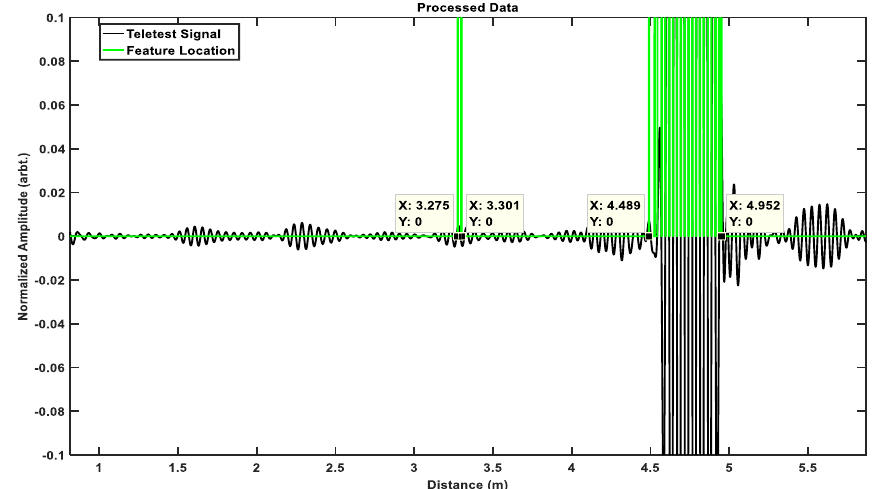
Figure 9. Calculated threshold using method three on Test 5 (red) against the second version comparisonValue (black). In the case of method one, the threshold would be a constant line instead of changing based on the iteration. Appl. Sci. 2018 , 8 , x FOR PEER REVIEW 15 of 24